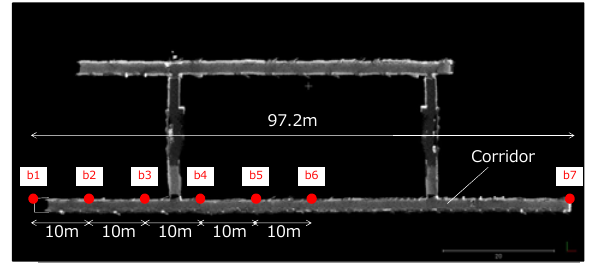
Figure 9. Positions of iBeacon transmitters